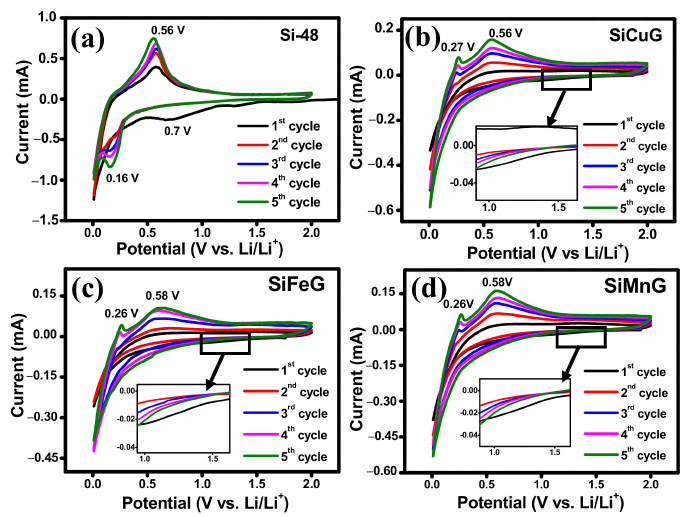
Figure 8. Cyclic voltammograms for 1–5 cycles of ( a ) Si-48, ( b ) SiCuG, ( c ) SiFeG, and ( d ) SiMnG vs. Li/Li + as a counter electrode with 1 M LiPF 6 in EC:DEC:FEC ( v / v ratio of 5:70:25) at 0.1 mV s − 1 scan rate in the potential window of 0.01–2.0